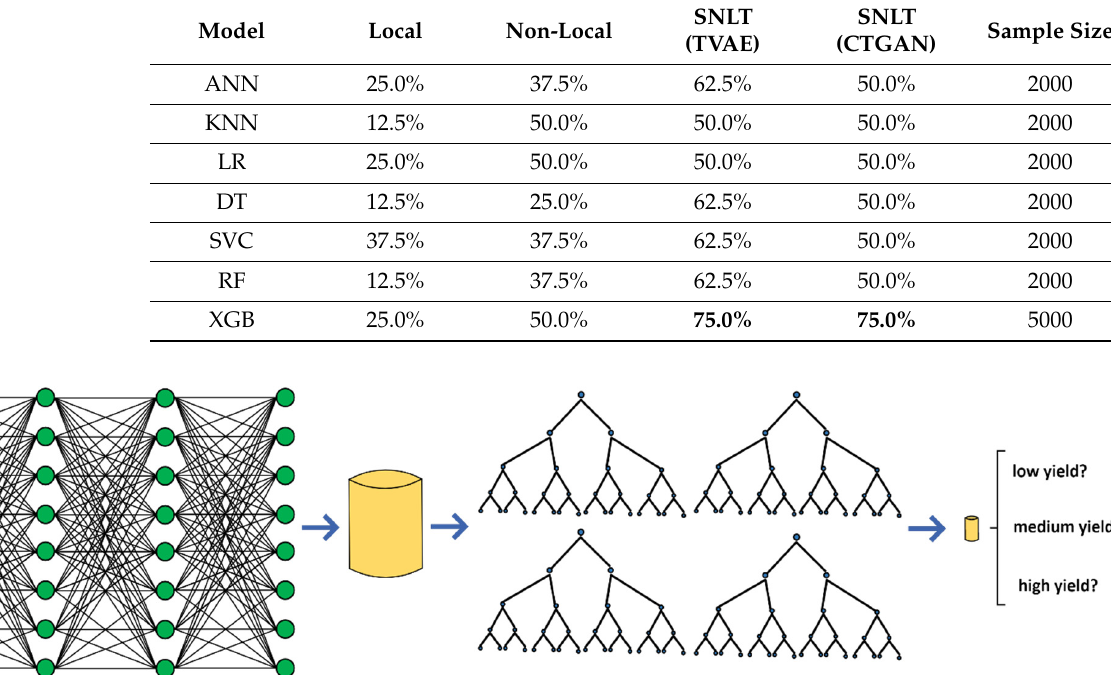
Figure 1. The SNLT Pipeline. Original data fed to a data synthesizer like CTGAN, which outputs lager dataset. Synthesized dataset used to train models like XGBoost. Trained model classifies very small target dataset.